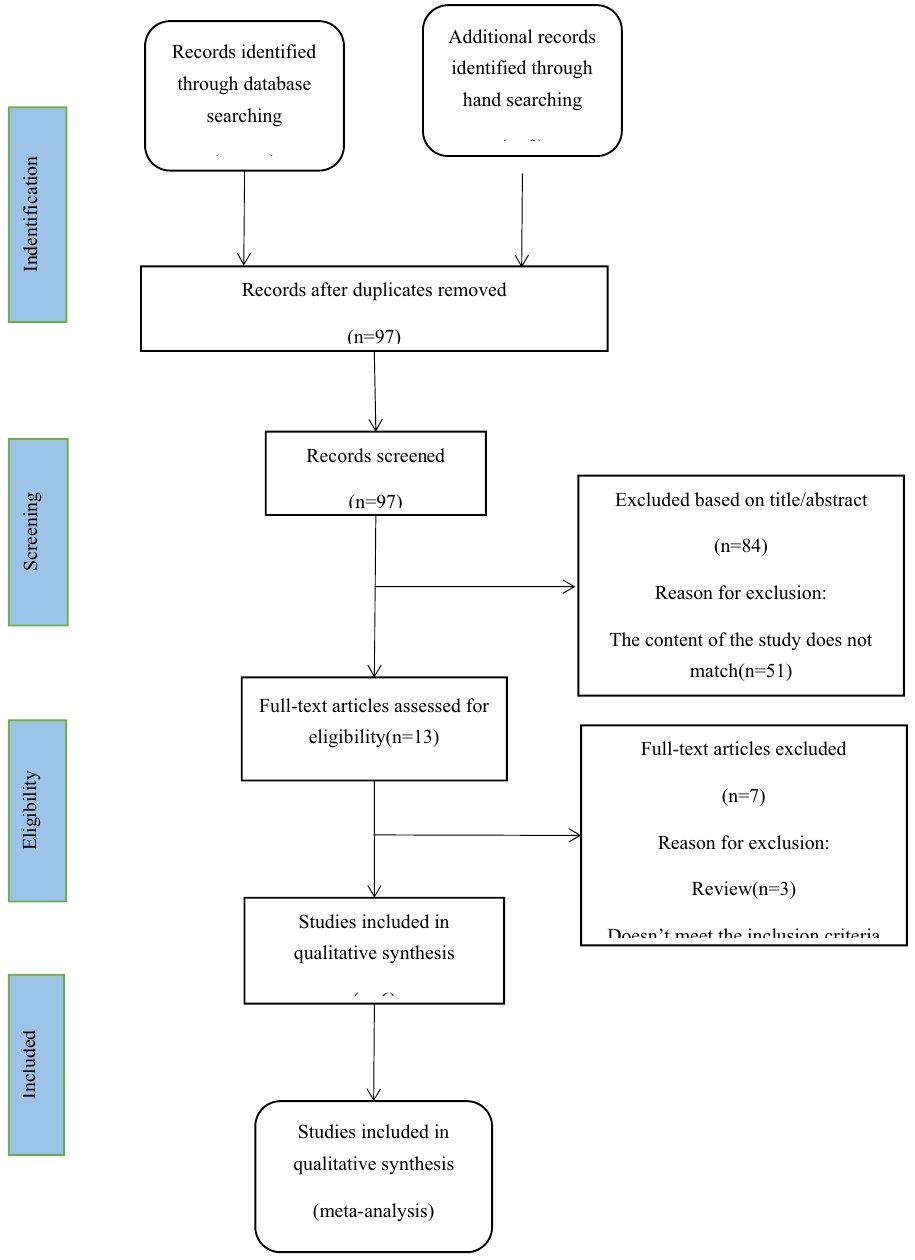
Figure 2. Flowchart of included